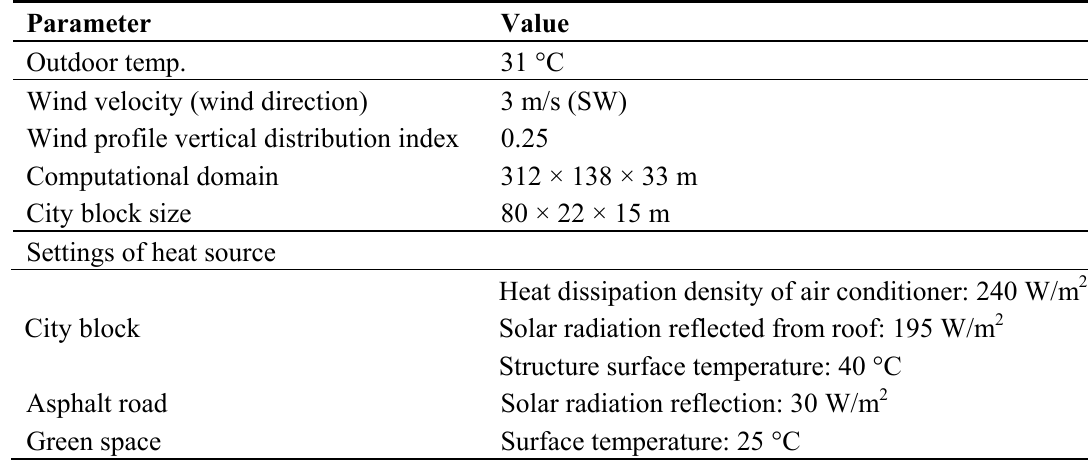
Table 5. Parameters used in the CFD